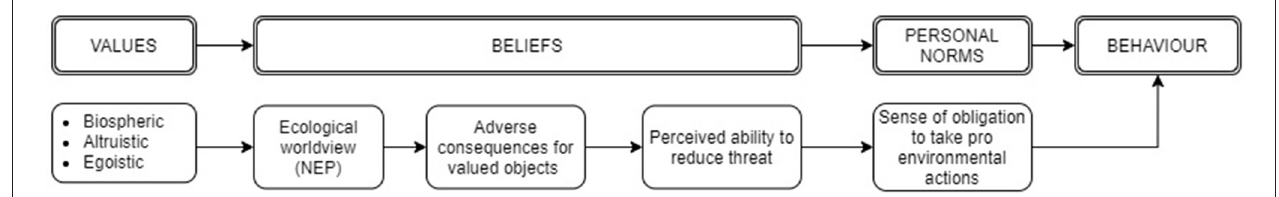
FIGURE 1 | Representation of the VBN theory of environmentalism. Arrows represent direct effects. Adapted from Dietz et al. (2005) and Stern (2000).